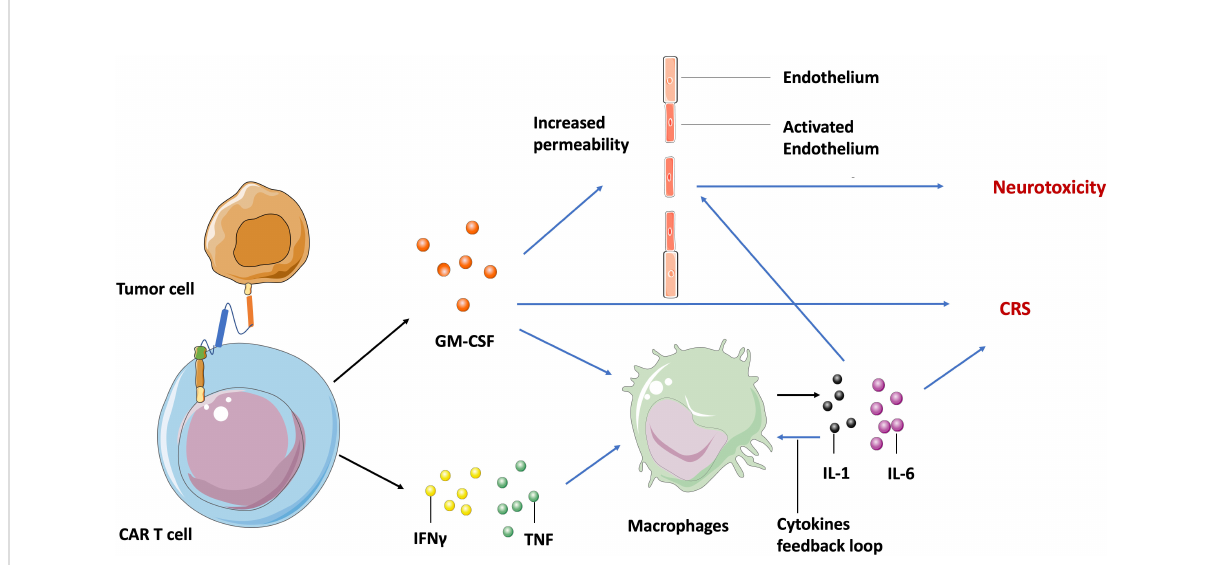
FIGURE 2 Molecular mechanism of CAR T cell-induced CRS and neurotoxicity. After recognizing tumor speci fi c antigens, activated CAR T cells secret GM- CSF, TNF, and IFN g , leading to the release of IL-1 and IL-6 by macrophages and other immune cells, which in turn activates macrophages to form a cytokine feedback loop. The GM-CSF and IL-6 may activate endothelium cells in the brain vasculature to increase its permeability. Blue arrow indicates the upregulation and activation of pathways. Black arrow indicates the molecules